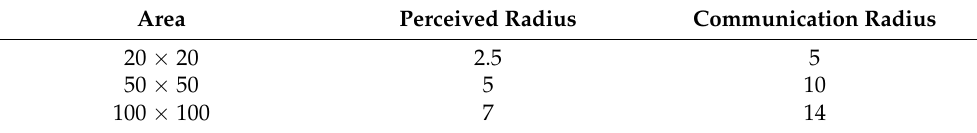
Table 1. Experimental